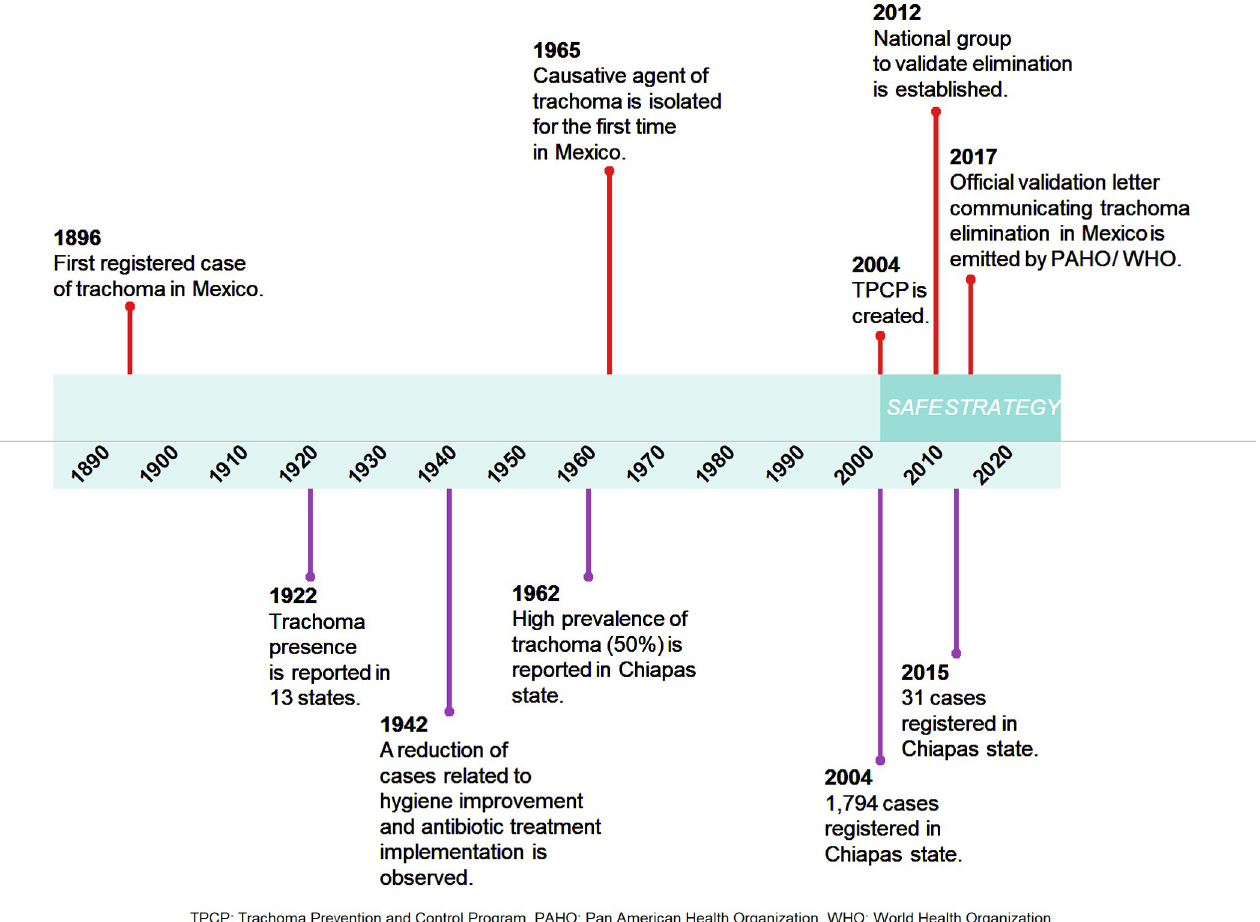
Fig 2. Milestones in the trachoma elimination in Mexico, 1890 to 2020. Source: Own elaboration based on extraction of data from dossier [13].